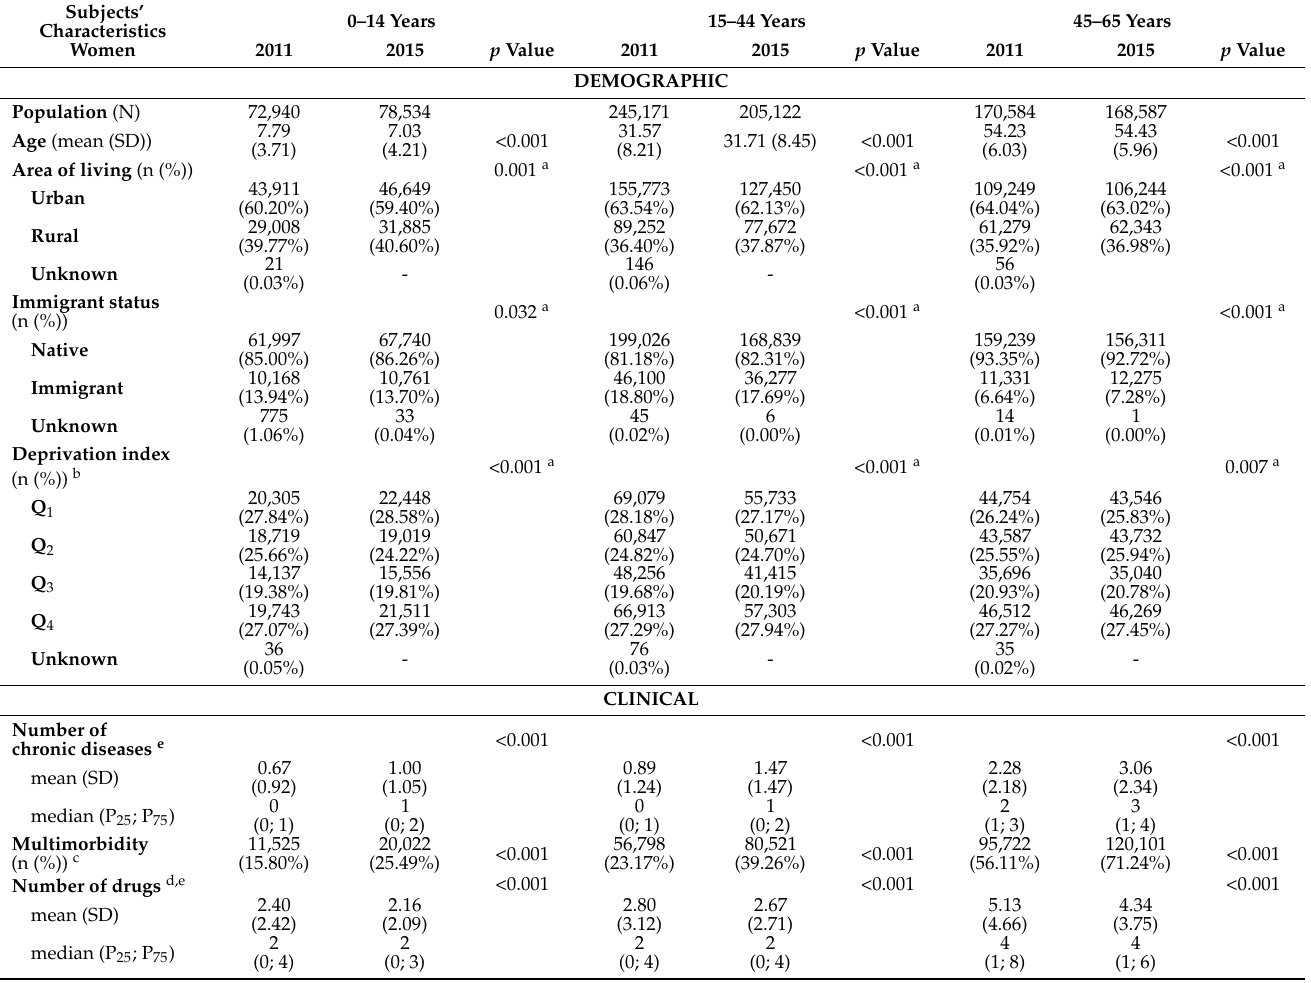
Table 1. Demographic and clinical characteristics of women in 2011 and